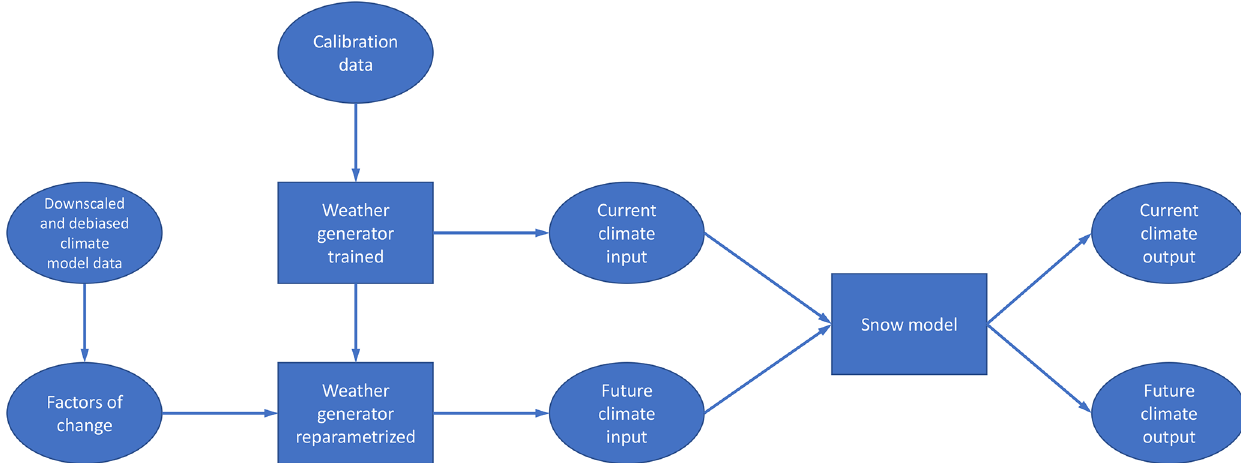
Figure 2. Flow chart of the modelling